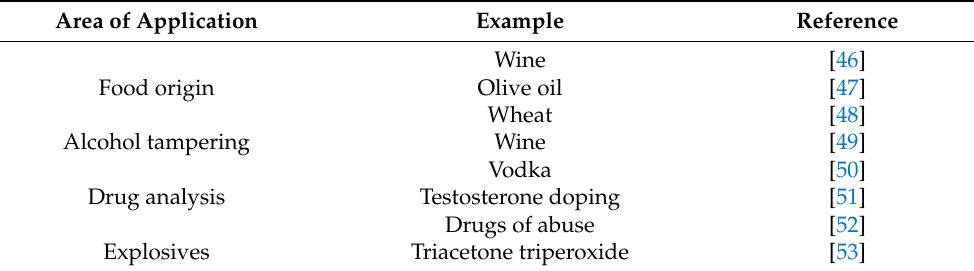
Table 2. Selected examples of IRMS applications in forensic